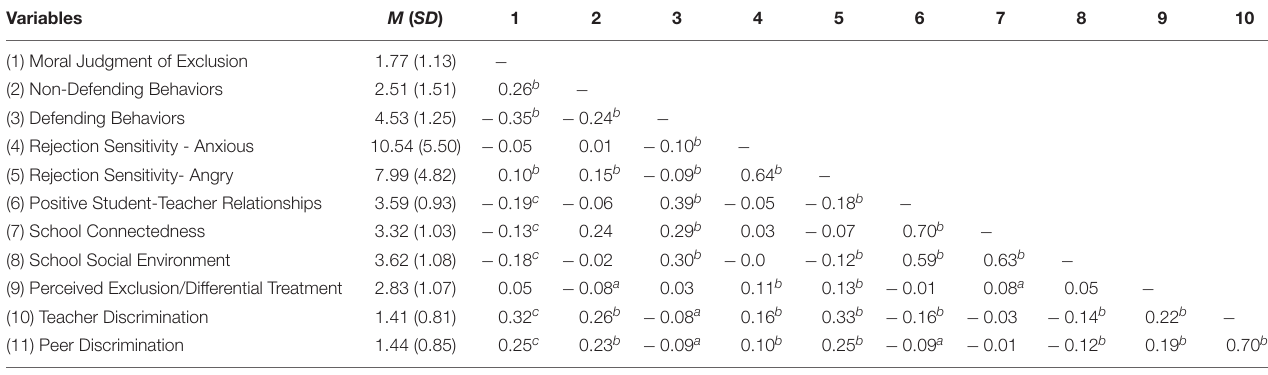
TABLE 1 | Means, standard deviations, and correlations between variables.